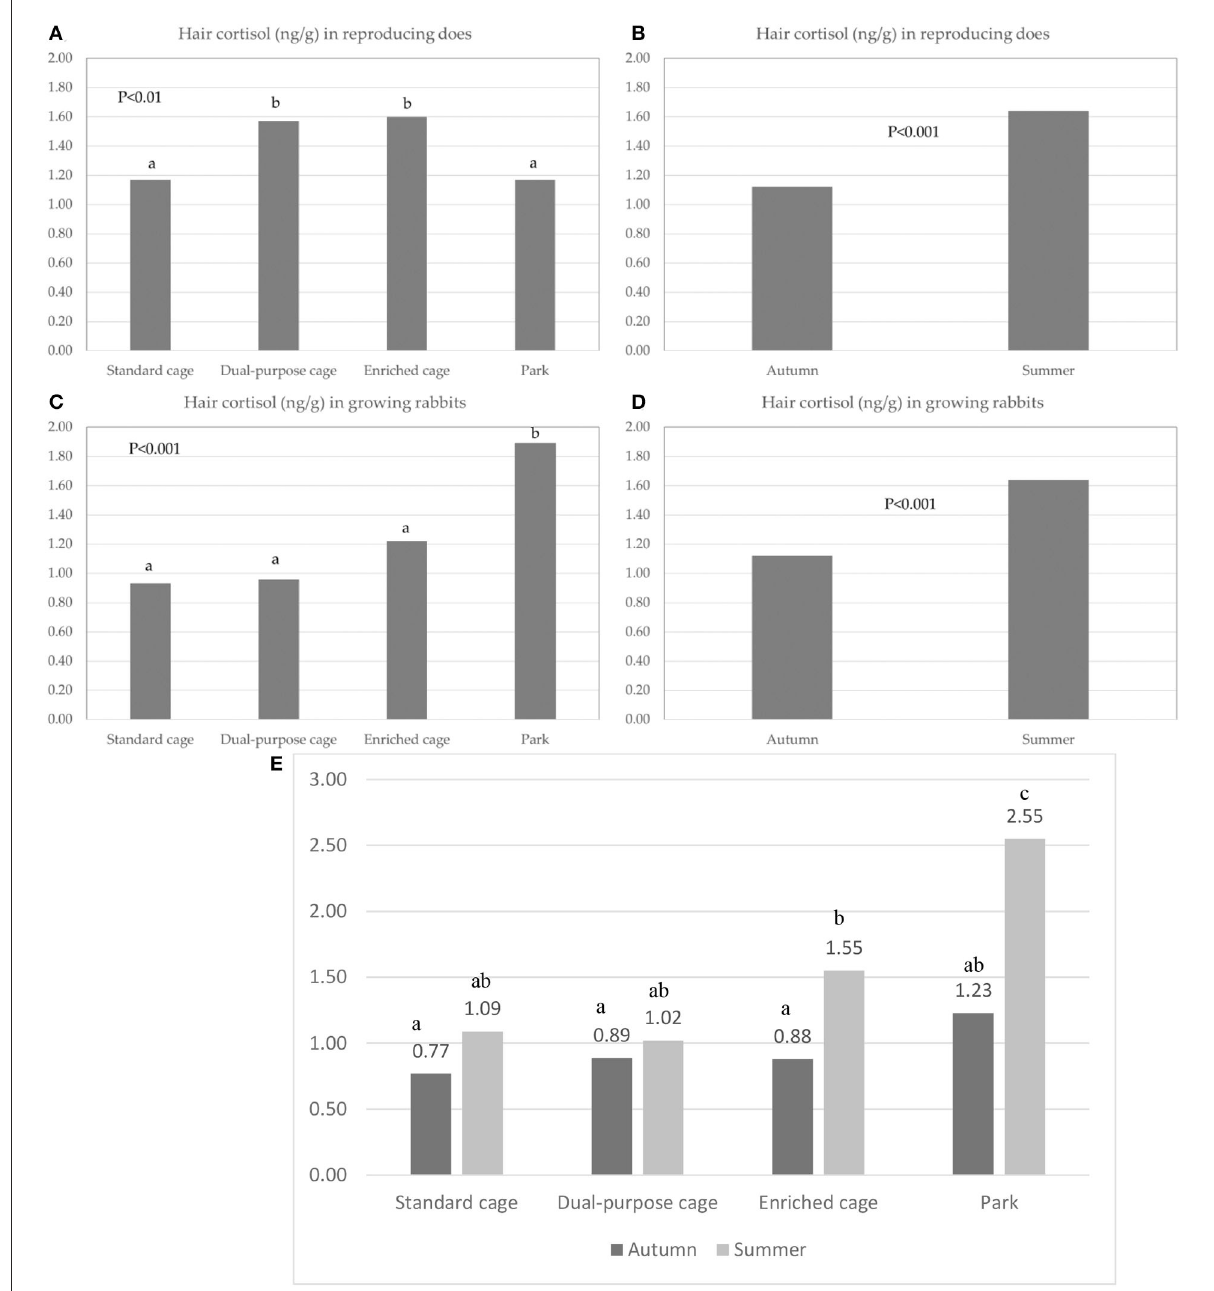
FIGURE1 Hair cortisol content (ng/g): effect of the housing system (A) and the sampling season (B) in reproducing does; effect of the housing system (C) , the sampling season (D) , and the interaction between housing systems and sampling season (E) in growing rabbits. Different letters indicate a significant difference at P -value <